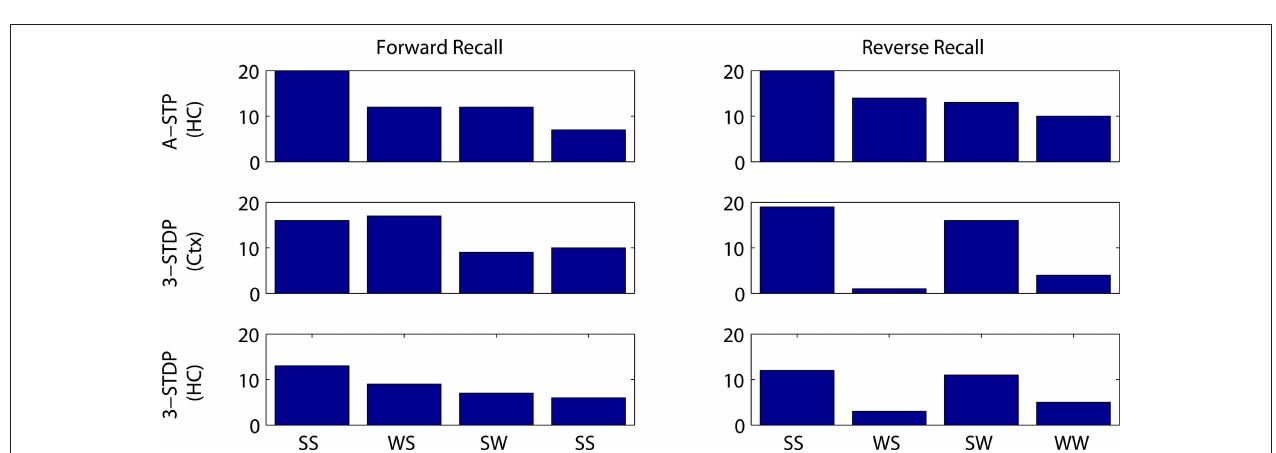
Figure 7 | Mean change in synaptic weights between cell groups as a function of stimulus strengths and plasticity mechanism. Fractional change in synaptic strength is plotted. (Left) Connections needing strengthening for forward recall. W1–C1 = first word to context-1. C1–W2 = context-1 to second word. (Right) Connections needing strengthening for reverse recall. W2–C1 = second